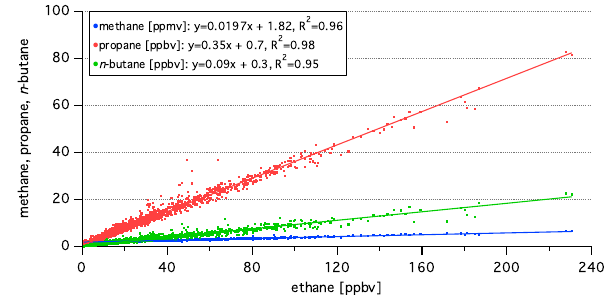
Figure 7. Correlation of methane, propane and n -butane with ethane at Boulder South Road (BSR) from 2010 to